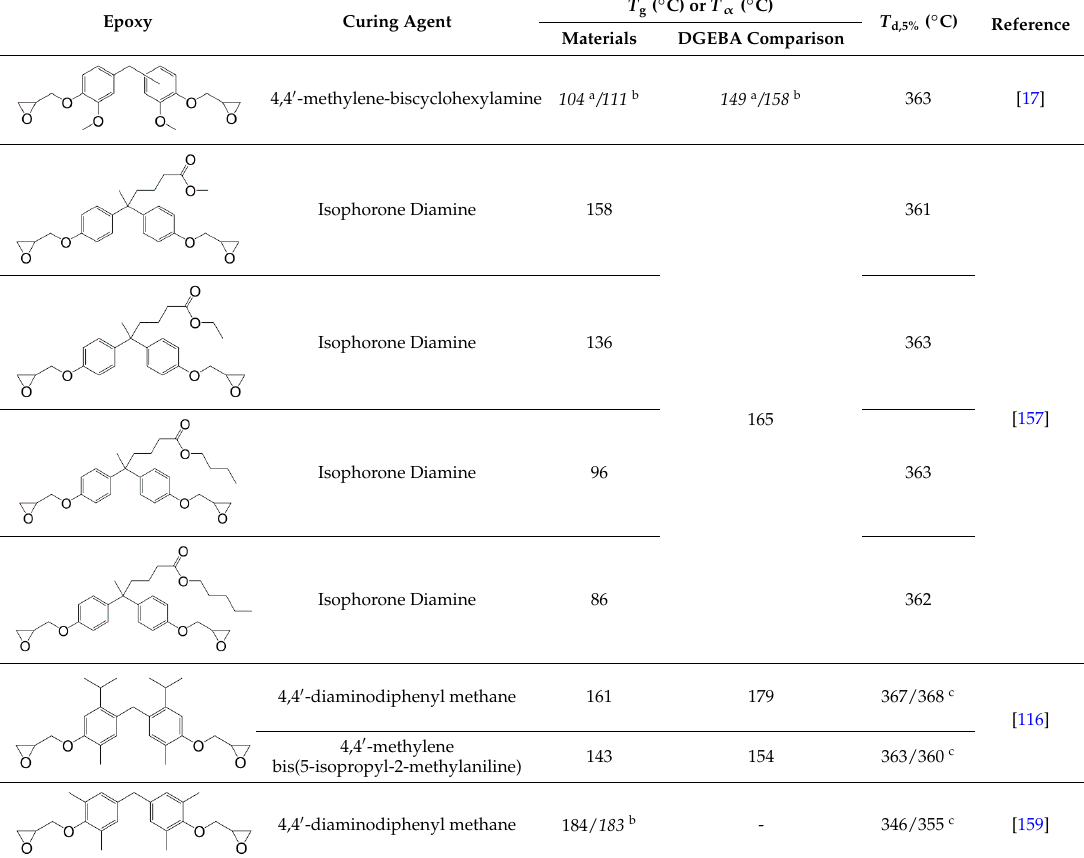
4,4 (cid:48) -diaminodiphenyl methane 184/ 183 b - 346/355 c [159] a T b T α measured by DMA at the peak position of loss modulus curve; α measured by DMA at the maximum of tan δ ; c T d under air Table 4. Di-epoxy monomers with two aromatic rings separated by more than one atom exhibiting ester Table 4. Di-epoxy monomers with two aromatic rings separated by more than one atom exhibiting ester Table 4. Di-epoxy monomers with two aromatic rings separated by more than one atom exhibiting ester maximum of tan δ ; c T d under air flow. Table 4. Di-epoxy monomers with two aromatic rings separated by more than one atom exhibiting ester or amide bonds, and thermal properties of the cured materials. Table 4. Di-epoxy monomers with two aromatic rings separated by more than one atom exhibiting ester Table 4. Di-epoxy monomers with two aromatic rings separated by more than one atom exhibiting ester or amide bonds, and thermal properties of the cured materials. or amide bonds, and thermal properties of the cured materials. Table 4. Di-epoxy monomers with two aromatic rings separated by more than one atom exhibiting ester or amide bonds, and thermal properties of the cured materials. or amide bonds, and thermal properties of the cured materials. or amide bonds, and thermal properties of the cured materials. or amide bonds, and thermal properties of the cured materials.